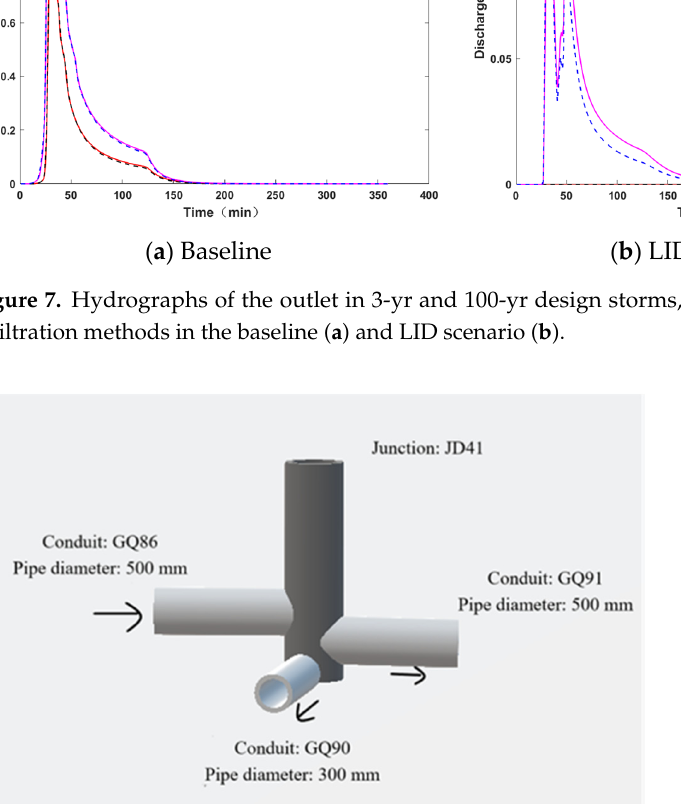
Figure 8. The schematic of the bifurcating junction above the outlet.